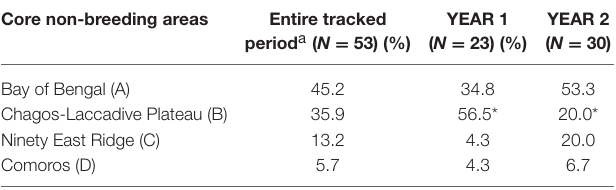
TABLE 2 | Percentage of birds that migrated to the four distinct non-breeding grounds during the entire study period, and split between the two studied years (YEAR1: 2011–2012 and YEAR2: 2012–2013).